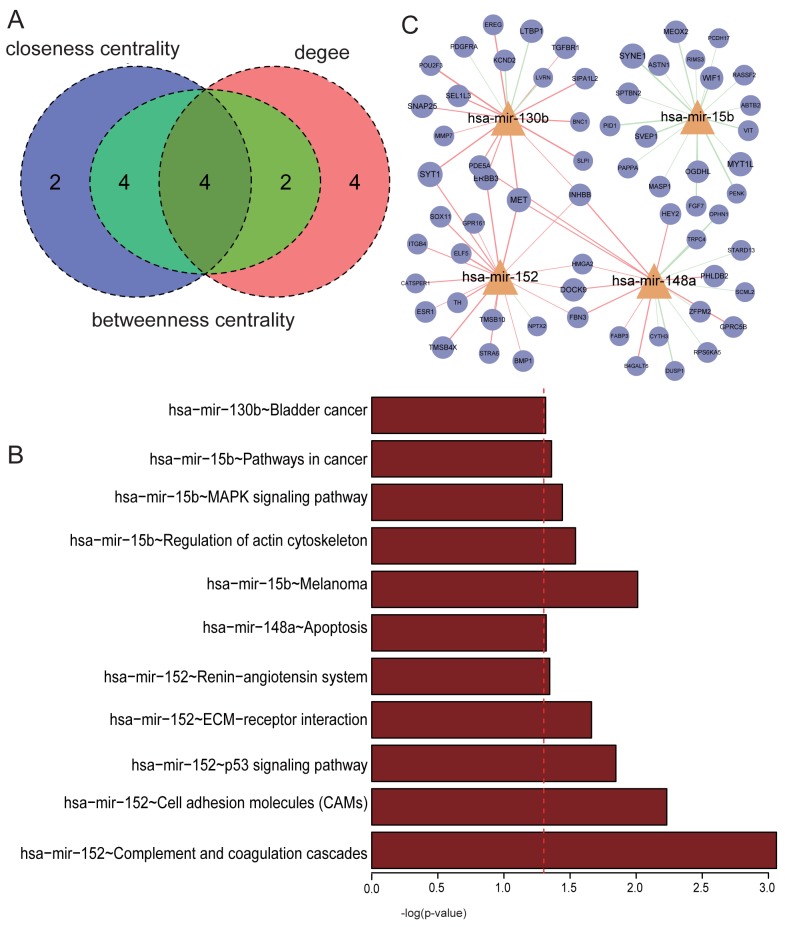
Topological analyses of the MGDRN.A.A Venn diagram of the top 10 maximum nodes in each dimension (with maximum degree, betweenness centrality, and closeness centrality). B. KEGG pathway enrichment analyses for dysregulated targets of four key miRNAs. The x-axis is -log10 of the P-value, and P< 0.05 was considered statistically significant. C. The subnetwork of four key miRNAs extracted from the MGDRN. Abbreviation is the same as in Fig 1.